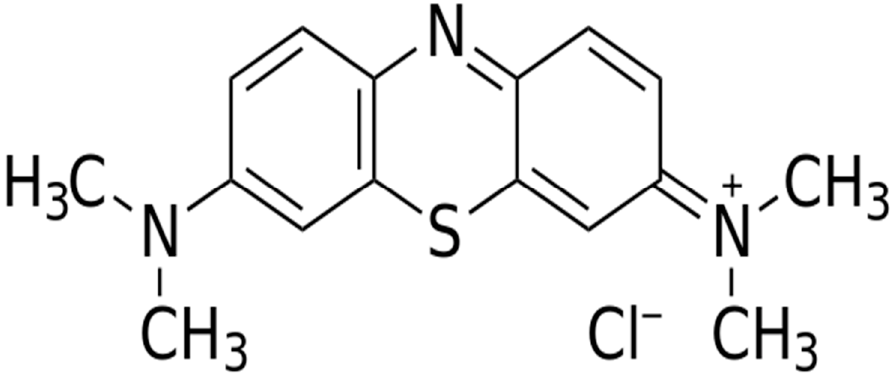
Figure 11. Structure of methylene blue. The preparation of pristine ZnO and Cl − -doped ZnO was performed via the sol- vothermal method by mixing zinc acetate di-hydrate (ZnC 4 H 6 O 4 ) and 25% ammonia as precursors for the fabrication of ZnO. Different concentrations of ammonium chloride (% w . w ), i.e., 5%, 10%, 15% and 20%, were mixed in 5 mL of ethanol in four beakers, and an ultrasonic bath was employed for 30 min to achieve sufficient dispersion. Then, 2.22 g of zinc acetate di-hydrate was dissolved by slowly adding 5 mL of 25% ammonia solution.